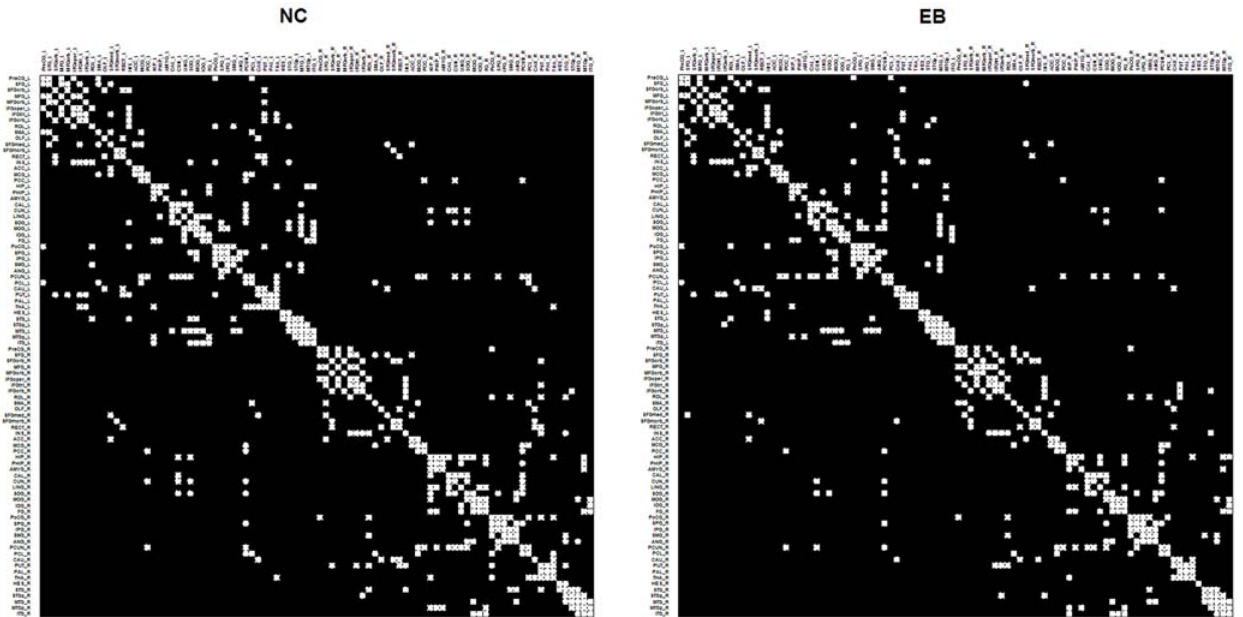
Figure 4. Backbone networks for the NC and EB groups. doi:10.1371/journal.pone.0007228.g004 PLoS ONE |